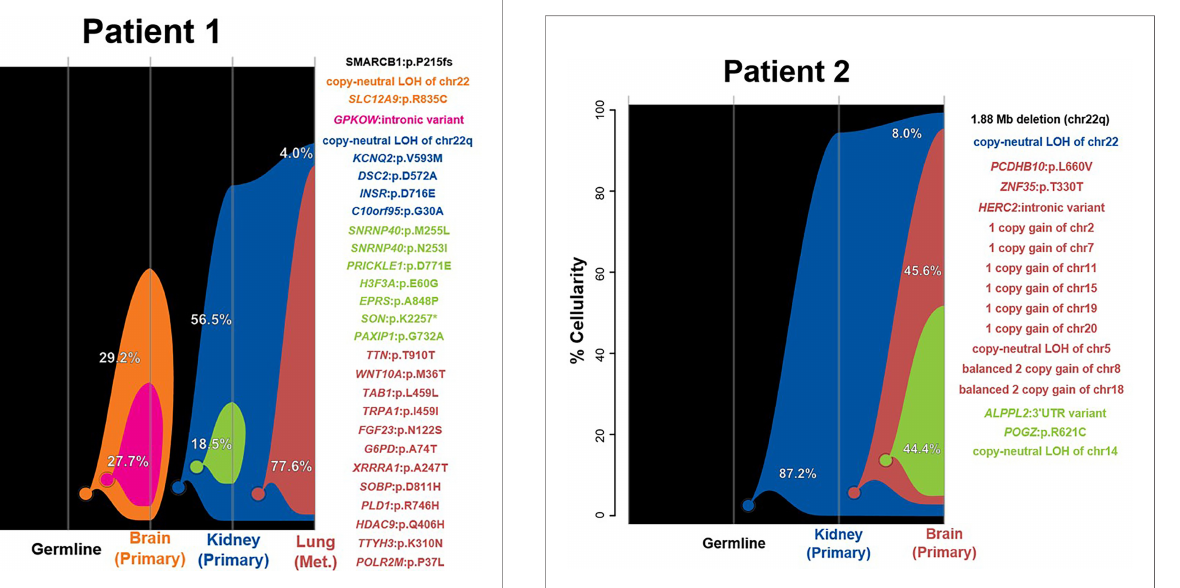
FIGURE 1 | – 3 Clonality analysis. River plots showing the composition of clones in multiple tumor samples plus matched normal blood (germline) sample. Vertical lines indicate a sample, labeled on the X-axis. Colored circles indicate the origins of a clone from a single cell, either of the germline (black) or a preceding clone. Colored outlines show the cellularity of clones (Y-axis) in each sample. The percentages shown (in white or black text) indicate the cellularity of a tumor clone in each sample that was identi fi ed, excluding the cells of any descendant clones. Clone percentages sum up to the total tumor cellularity of a sample. The samples are arranged to most clearly visualize clonal descent but do not represent a formal time-series. The copy number variants, loss-of-heterozygosity events, and single-nucleotide variants identi fi ed in the tumor samples as well as relevant germline predisposition variants are listed on the right and colored by which clone they belong to.